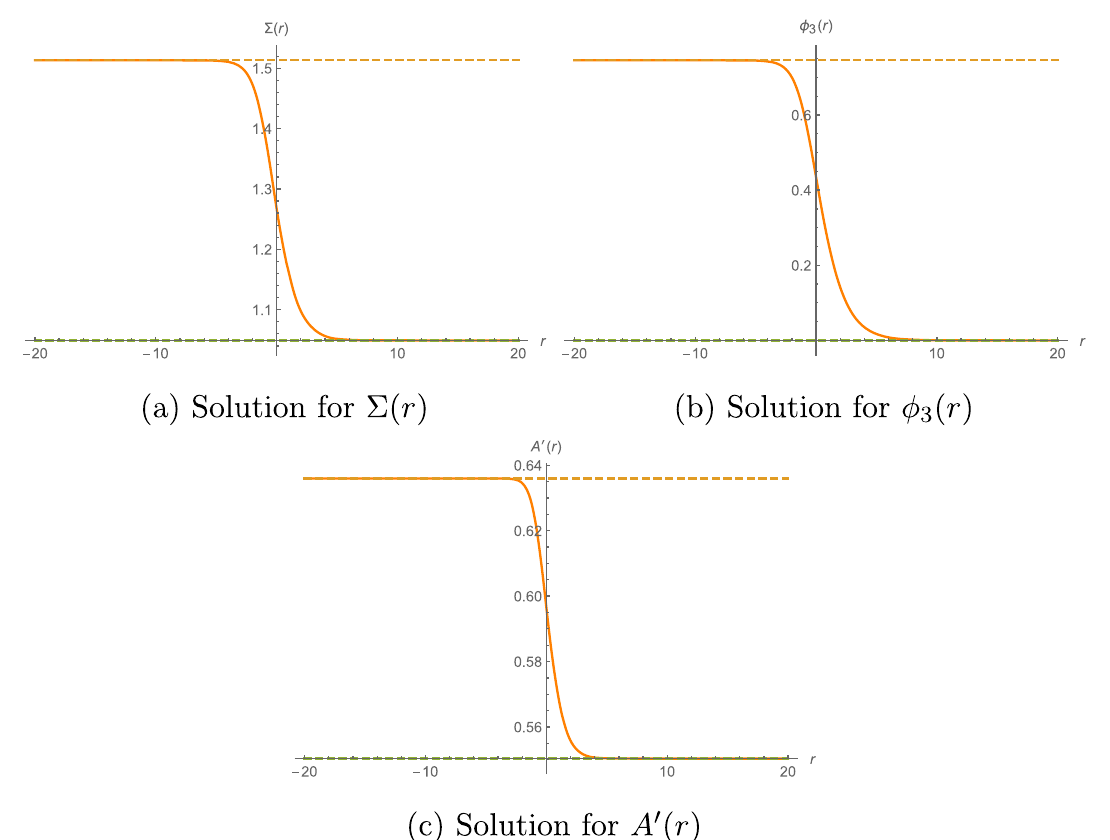
(cid:11) (cid:8) 1 − ζ along the flow ln 2 1 + ζ